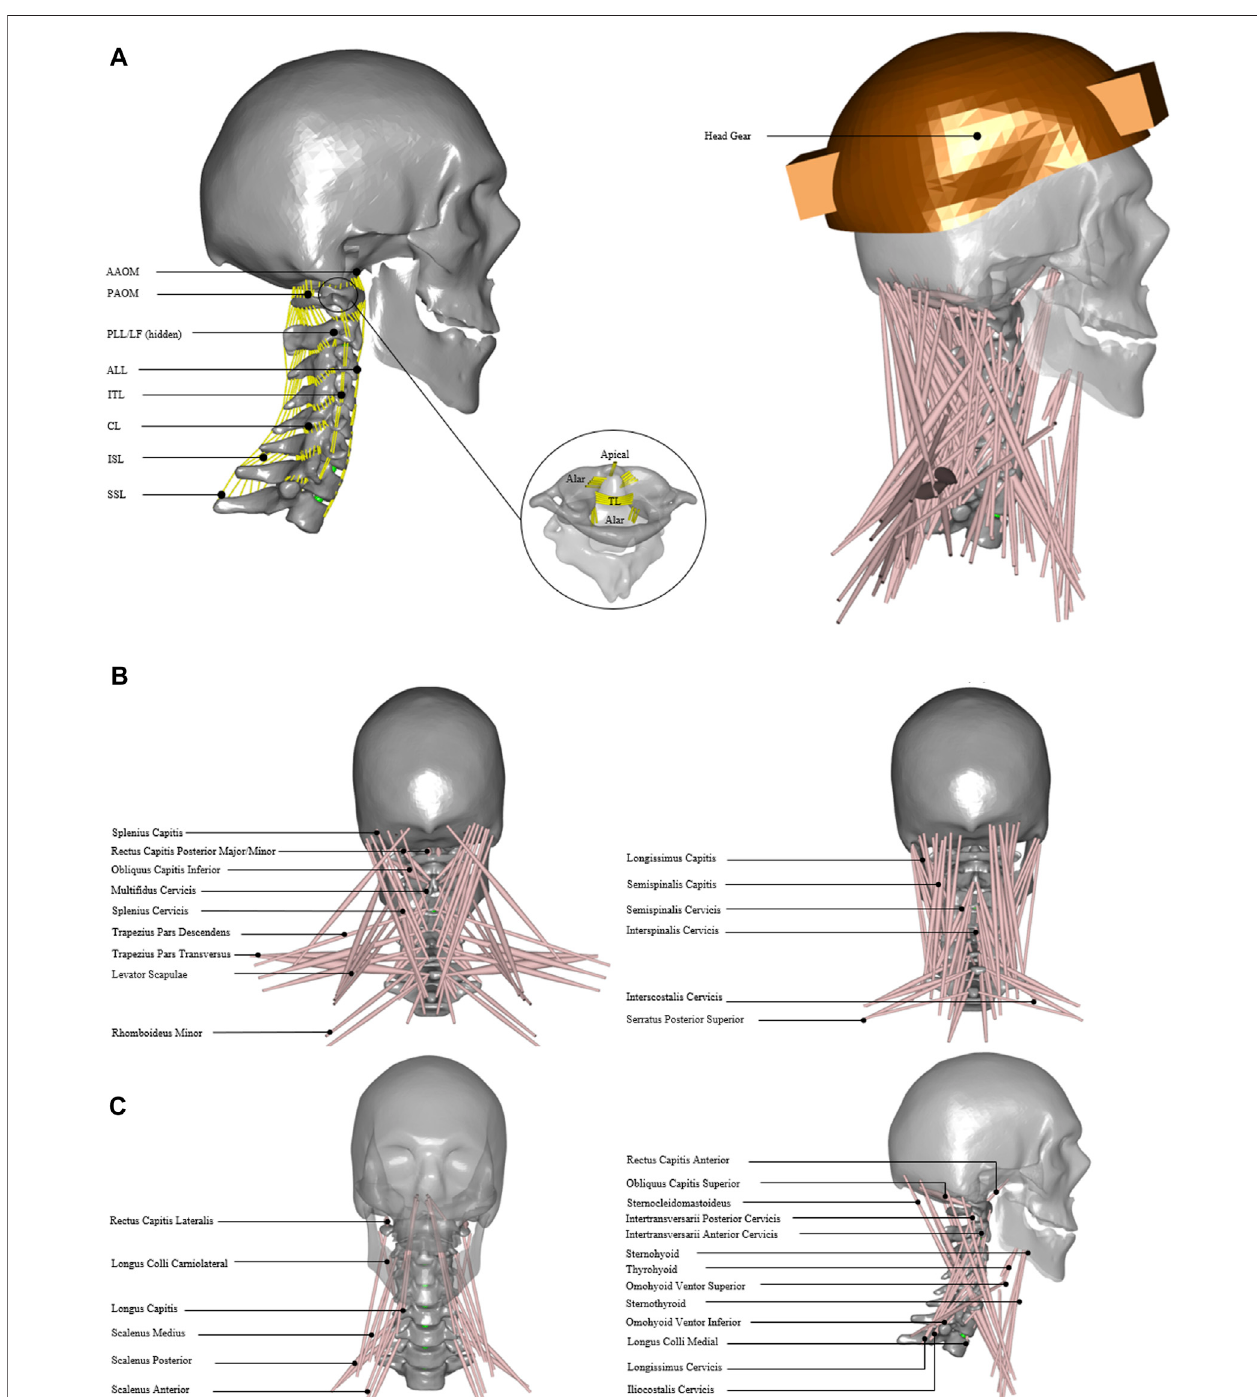
FIGURE 1 | Head and neck model. (A) Model with cervical ligament fi bers. Apical, alar, TL; transverse ligament, AAOM and PAOM; anterior and posterior atlantooccipital membranes, ALL; anterior longitudinal ligament, PLL; posterior longitudinal ligament, SSL; supraspinous ligament, ISL; interspinous ligament, ITL; intertransverse ligament, CL; capsular ligament, and LF; ligament fl avum. (B) Model with 34 muscle groups and headgear. (C) Detailed front, back, and side view of 34 muscle groups added in the model.